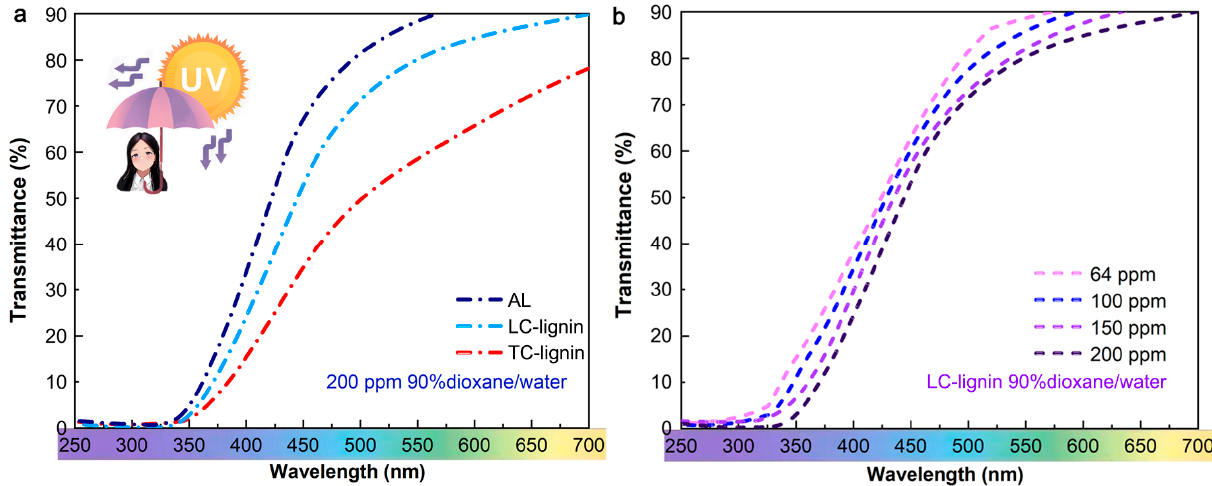
Figure 3. UV transmission spectra of ( a ) AL, LC-lignin, TC-lignin; ( b ) LC-lignin with different Figure 3. UVtransmissionspectraof( a )AL,LC-lignin, TC-lignin; ( b concentrations.